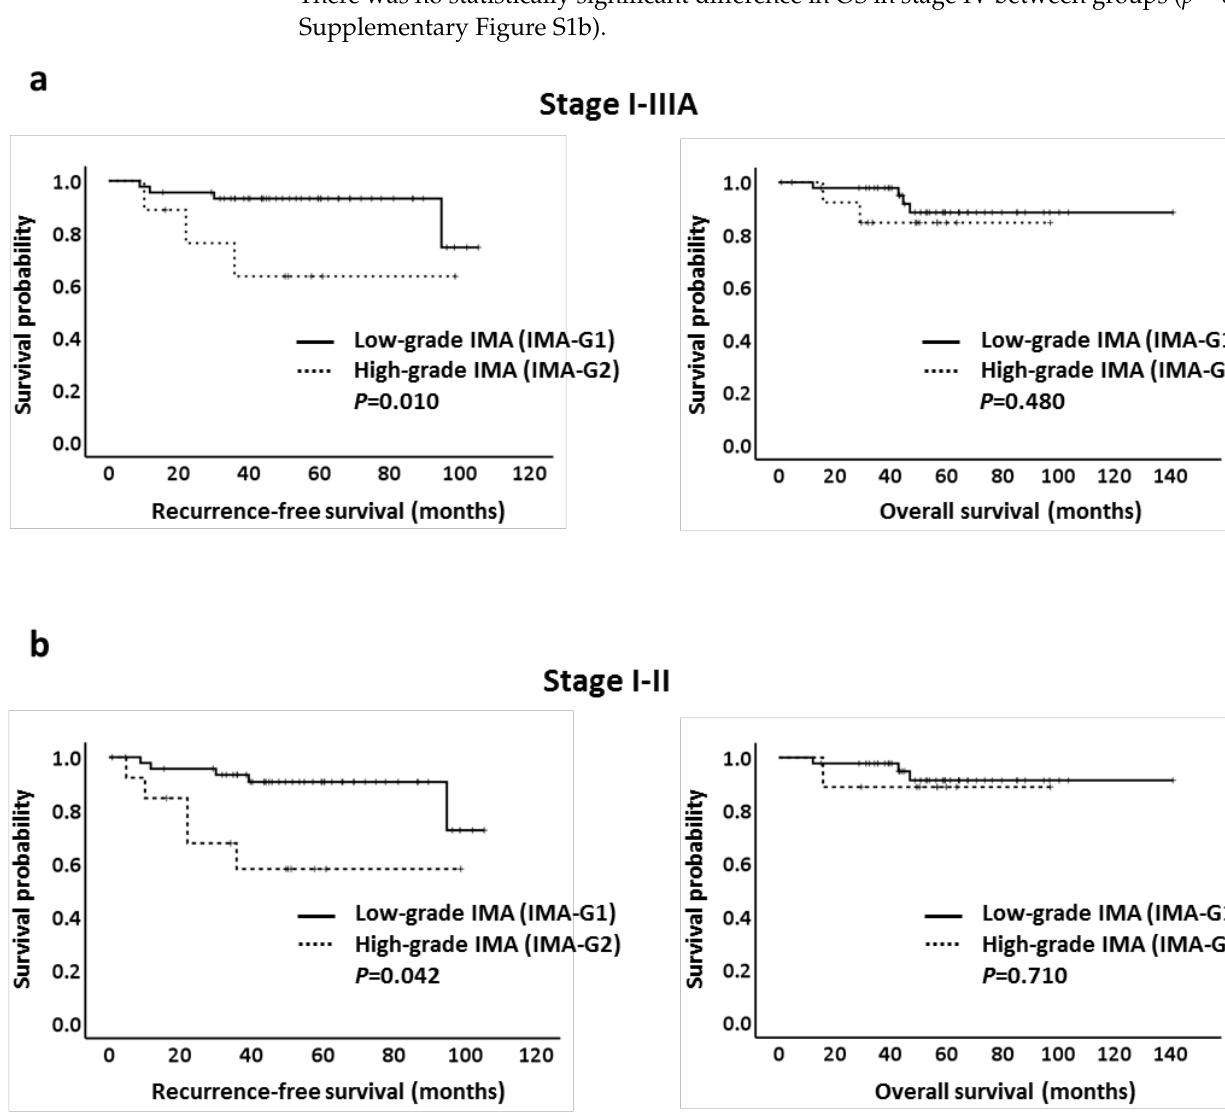
Figure 2. Kaplan–Meier curves of recurrence-free survival and overall survival in pulmonary invasive mucinous adeno- carcinoma patients with low-grade invasive mucinous adenocarcinoma (IMA) (IMA-G1) and high-grade IMA (IMA-G2) according to two-tier IMA-2 grading system. ( a ) Stage I–IIIA; ( b ) stage I – II.